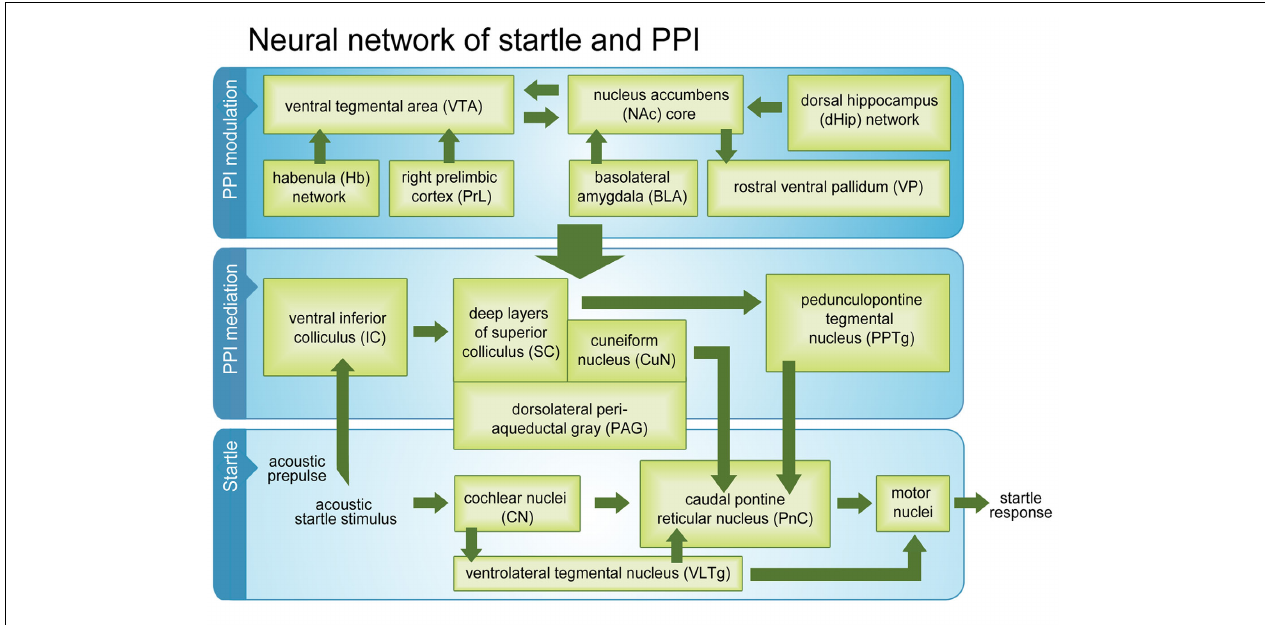
FIGURE 5 | Startle and PPI mediation pathways and PPI modulation network. Activated brain regions (green boxes) during a passive PPI session in intact rats. Beside classical startle and PPI mediation networks, the modulation network was fully activated.